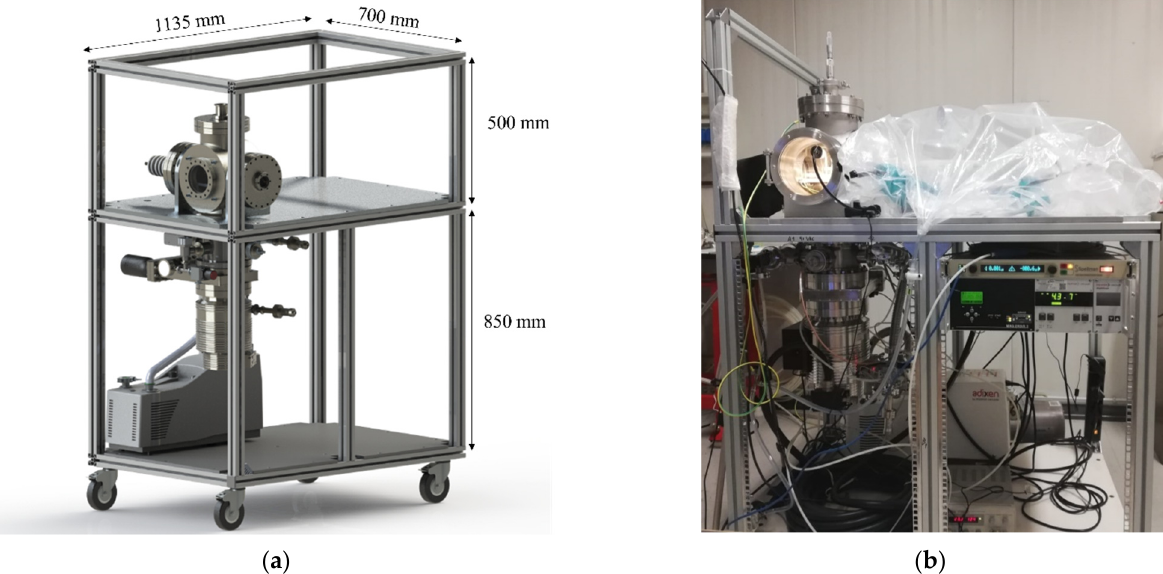
Figure 1. The HIVIPP apparatus developed in this work: ( a ) 3D assembly; ( b ) picture of the set-up installed at INFN-LNL for the LARAMED project.